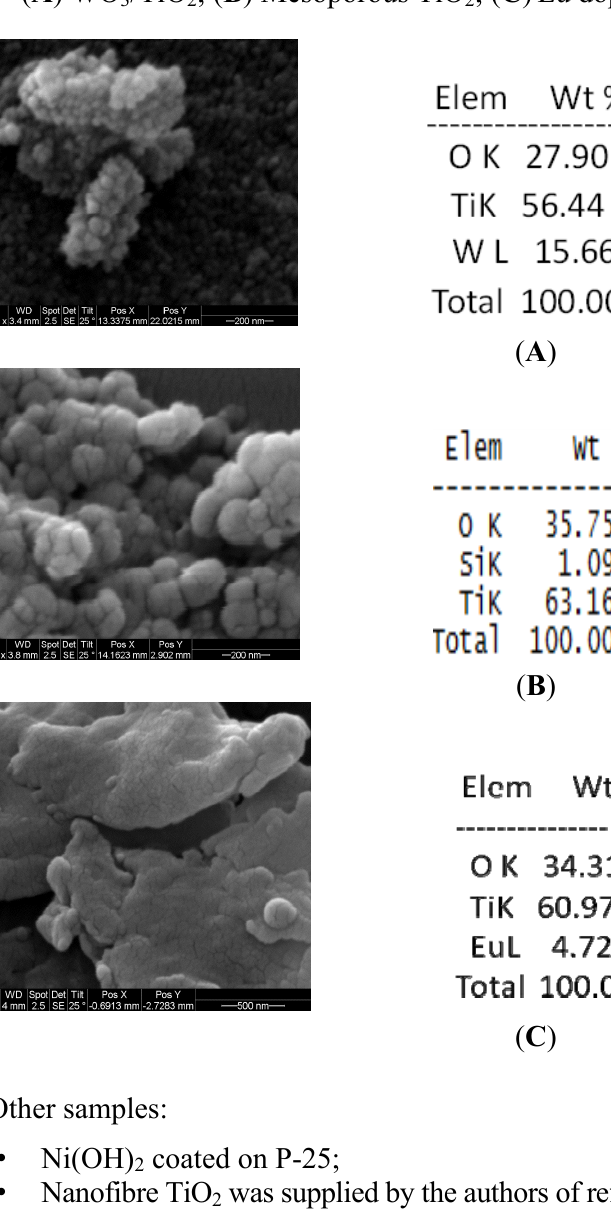
Figure A1. Scanning electron microscopy with X-ray microanalysis SEM/EDS was performed using a LEO 1530 (SEM images were taken with previous gold-coating) for: